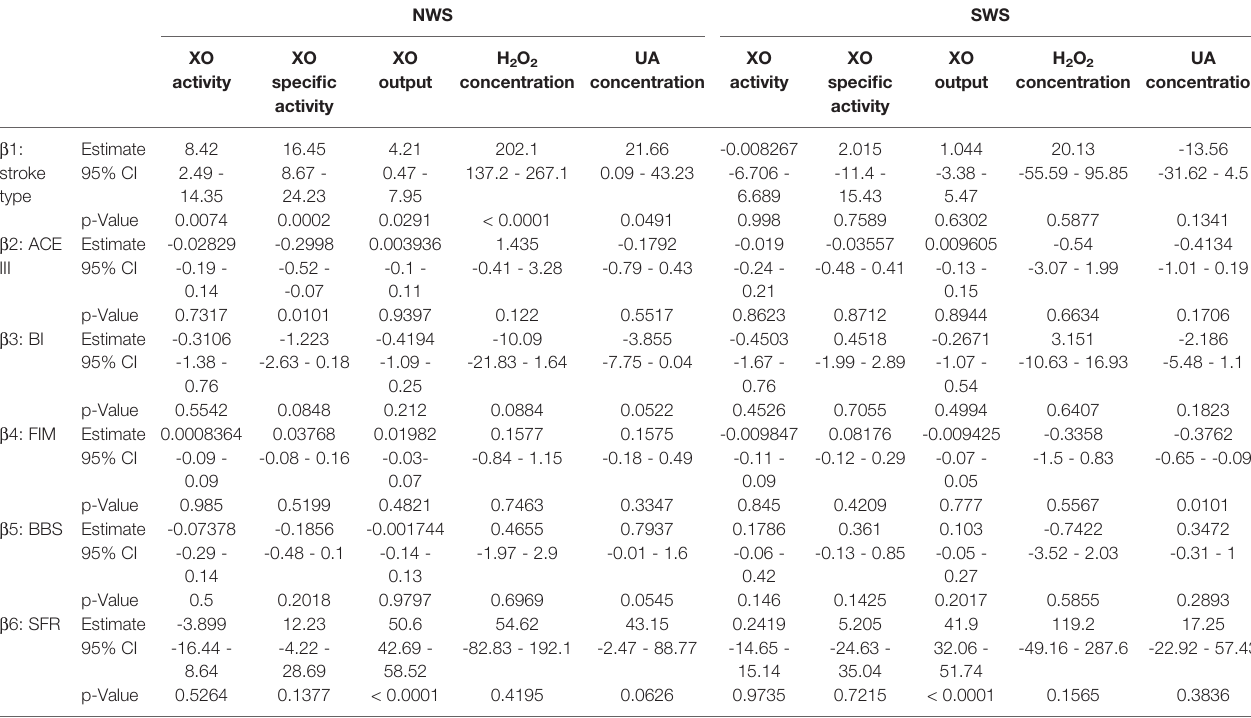
TABLE 5 | Multiple regression analysis of salivary ischemia biomarkers in all involved